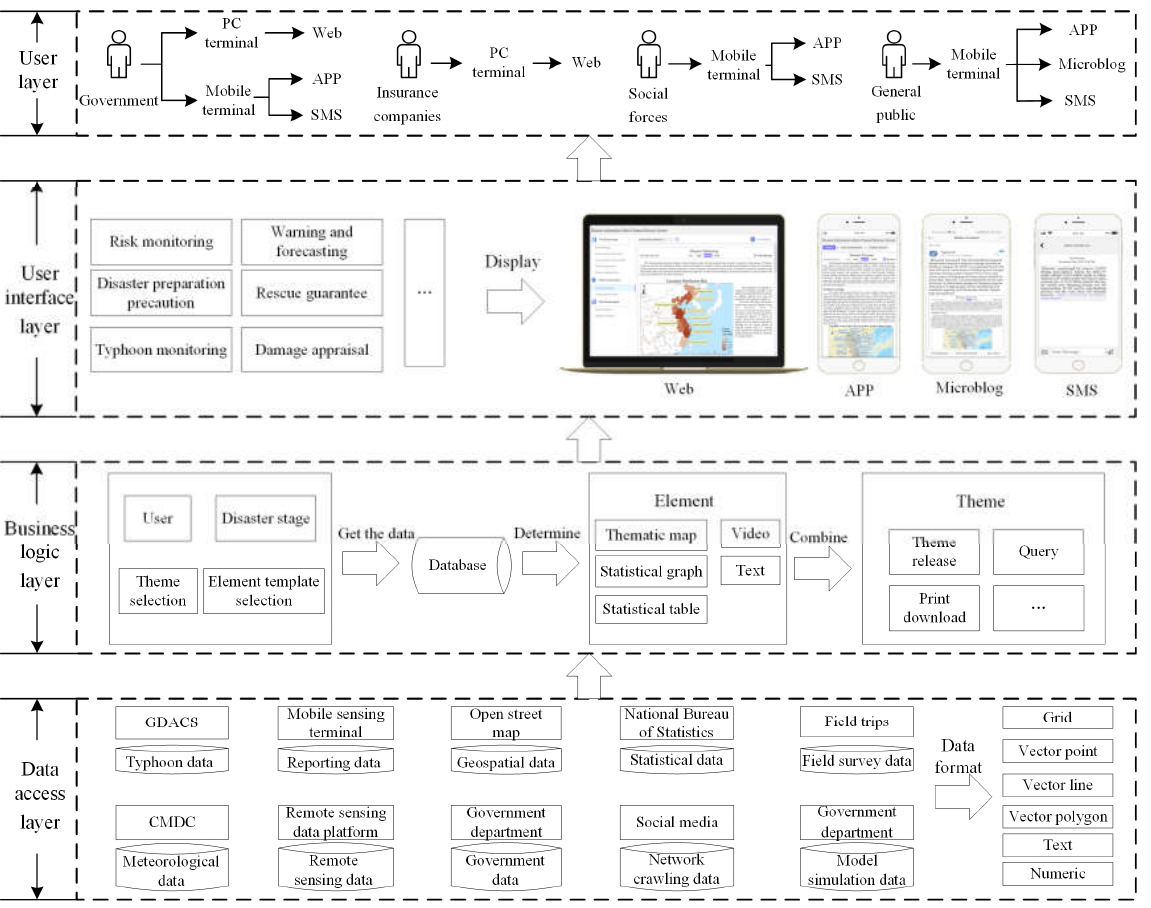
Figure 6. System architecture diagram.